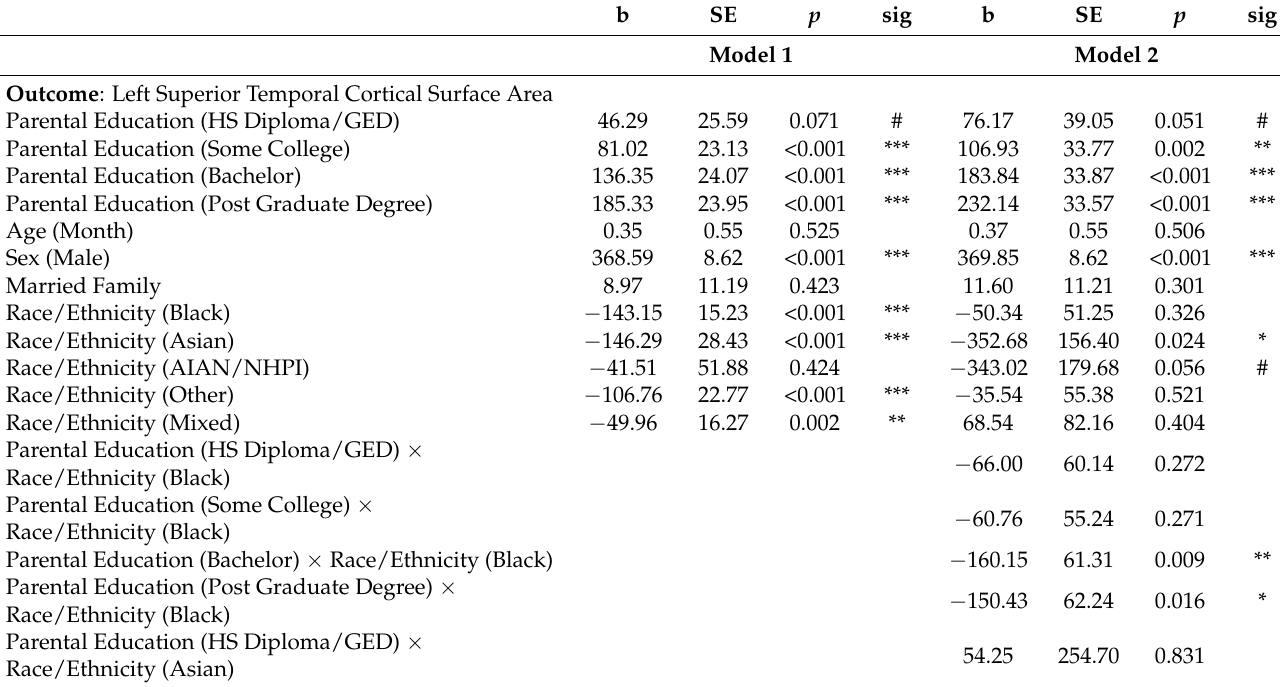
Table 4. Summary of mixed-effects regression models on the association between parental education and the left superior temporal cortical surface